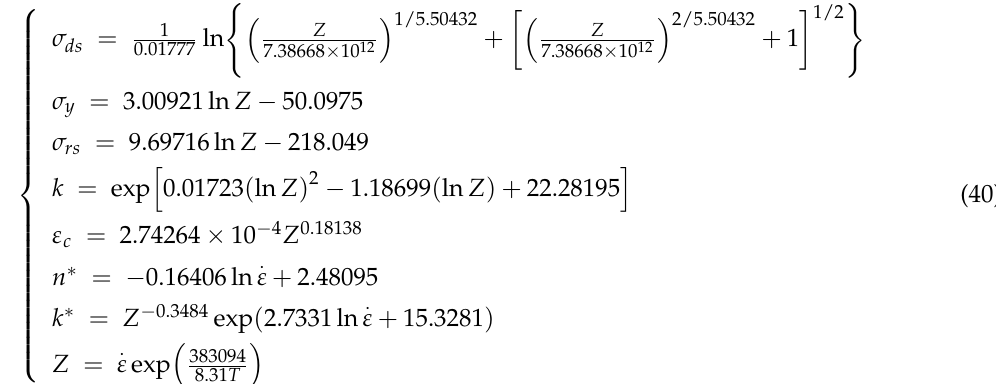
. . . . ε  ε  ε  ε  ε = 0.05 s − 1 ; ( b ) ε = 0. 1 s − 1 ; ( c ) ε = 0.5 s − 1 ; and ( d ) ε = 1 s − 1 = 0.05 s -1 ; ( b ) = 0. 1 s -1 ; ( c ) = 0.5 s -1 ; and ( d ) = 1 s -1 .